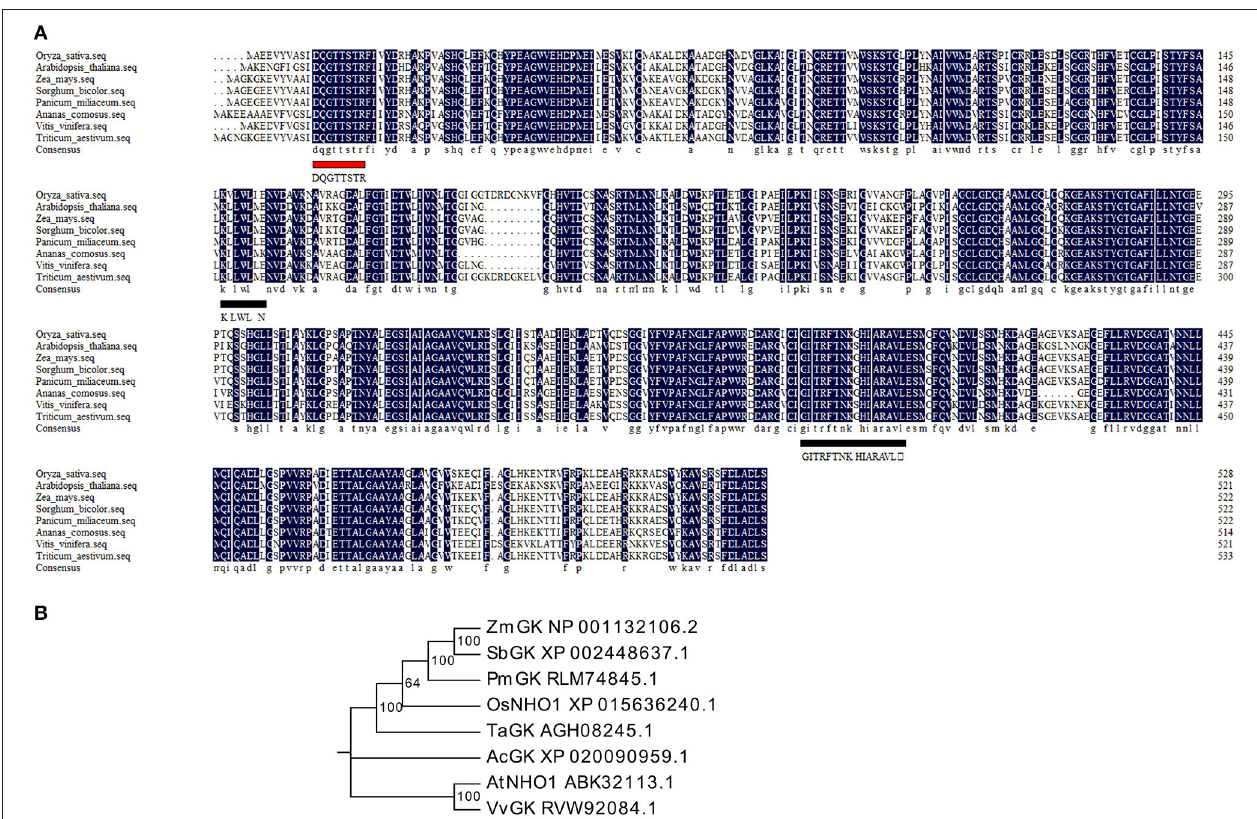
FIGURE 1 | Sequence and phylogenetic analysis of OsNHO1 and GK proteins from other species. (A) Protein sequence alignment using DNAMAN software. The ATP-binding motif is underlined with a red solid line. The FGGY signature motives are underlined with a black solid line. (B) Phylogenetic analysis of GK proteins constructed using Mega6 based on the neighbor-joining method. Oryza sativa (accession number: XP_015636240.1), Arabidopsis thaliana (accession number: ABK32113.1), Triticum aestivum (accession number: AGH08245.1), Zea mays (accession number: NP_001132106.2), Sorghum bicolor (accession number: XP_002448637.1), Panicum miliaceum (accession number: RLM74845.1), Ananas comosus (accession number: XP_020090959.1), and Vitis vinifera (accession number: RVW92084.1). GK, glycerol